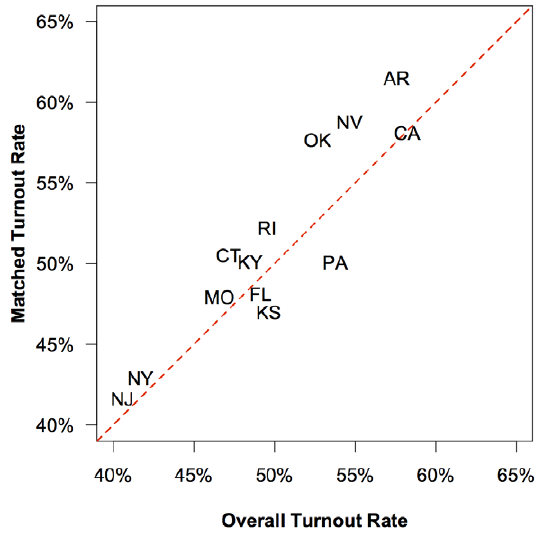
Figure 4. The proportion of Facebook users that were matched to the validated voting record by age and each age group’s proportion of the largest age group (those 20 years of age at the time of the election). This figure helps to explain why match rates are lower for Facebook users who tend to be younger and more difficult to match than the average registered